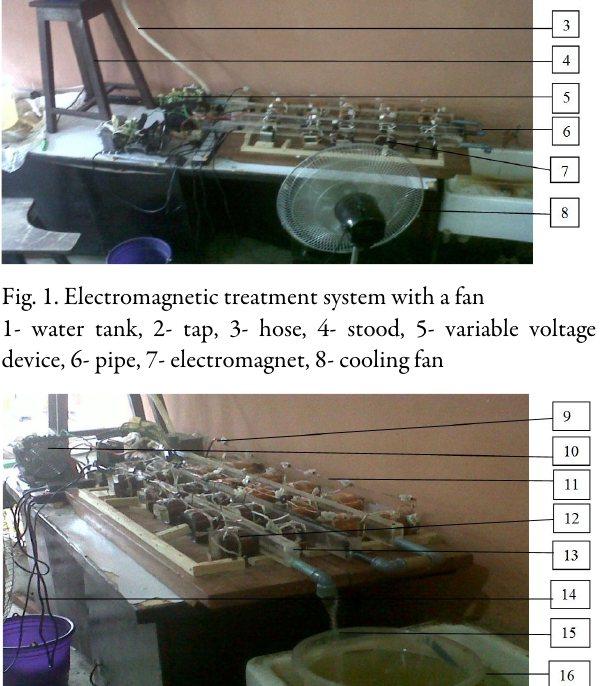
Fig. 2. Magnetically treated water from the electromagnet 9- positive terminal from variable voltage device, 10- variable voltage device, 11- distribution copper wire, 12- electromagnet with 180 turns of coil, 13- rectangular treatment chamber, 14- connecting wire to socket, 15- treated water from electromagnet, 16- bucket containing magnetically treated water.